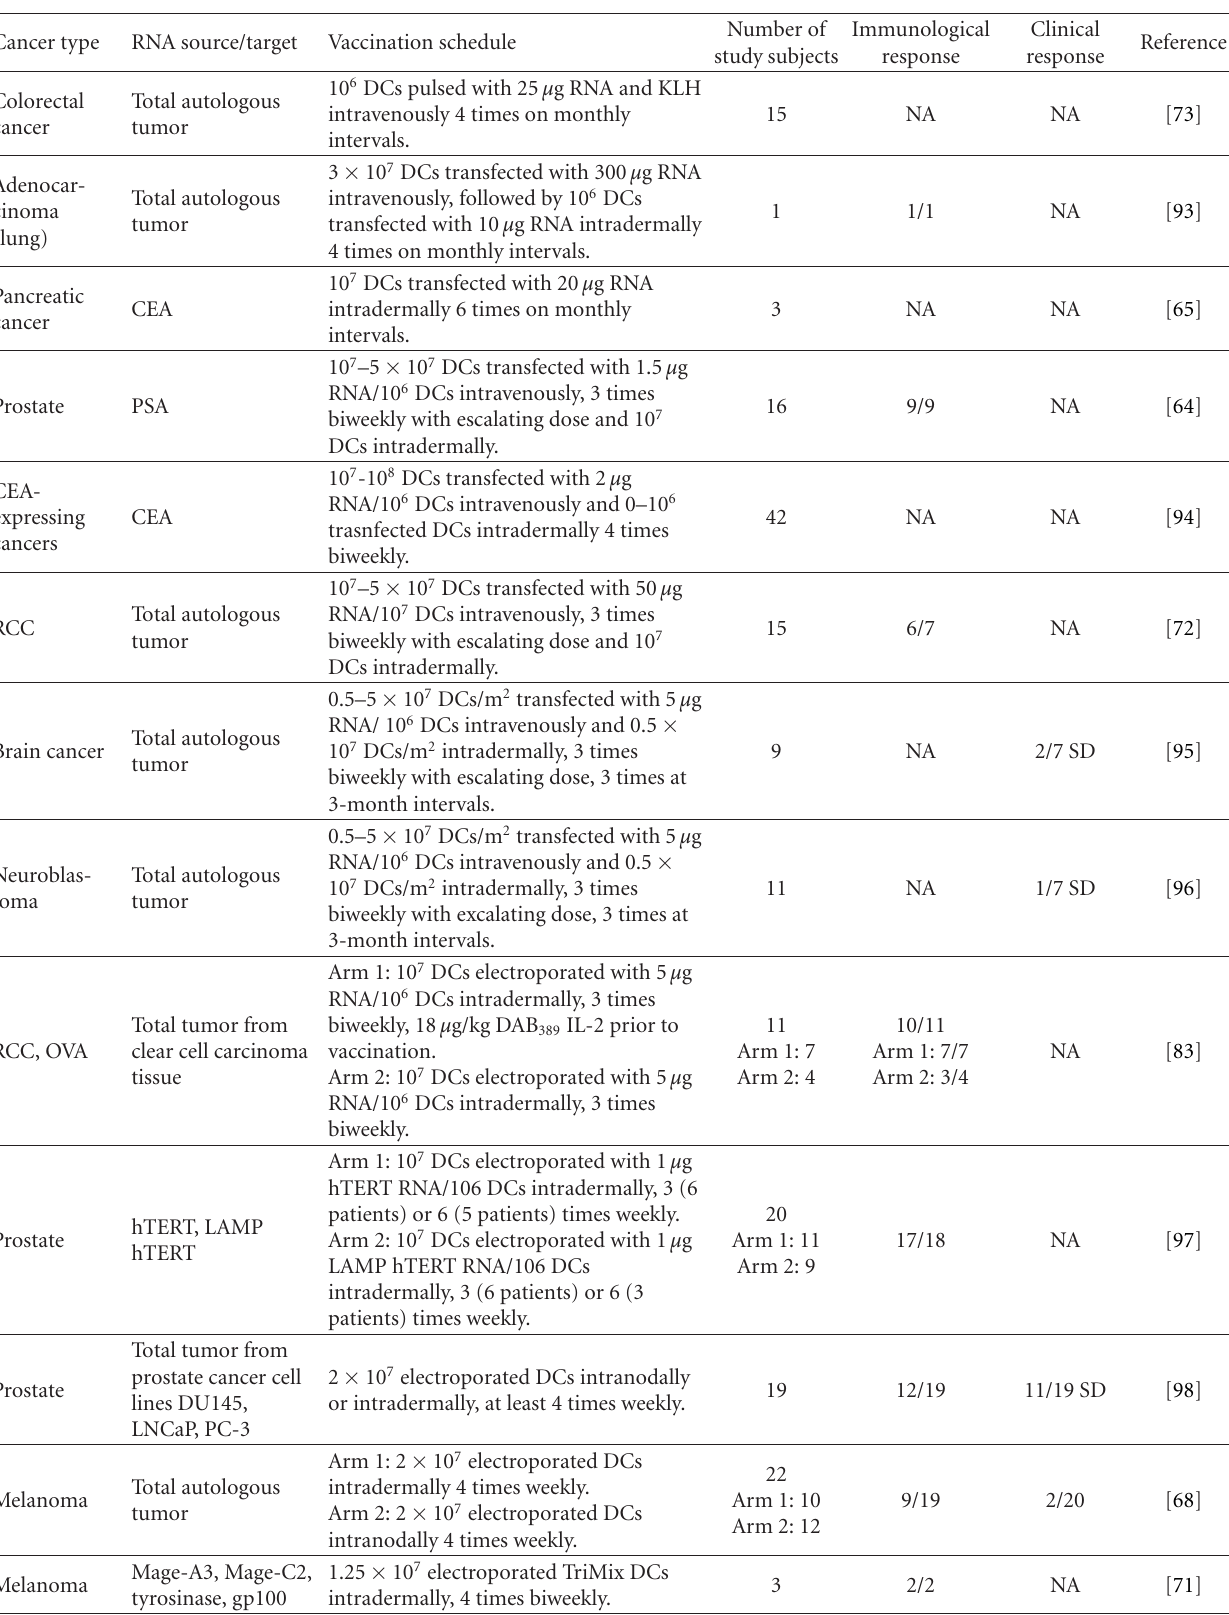
Table 1: Recent clinical trials using RNA-transfected